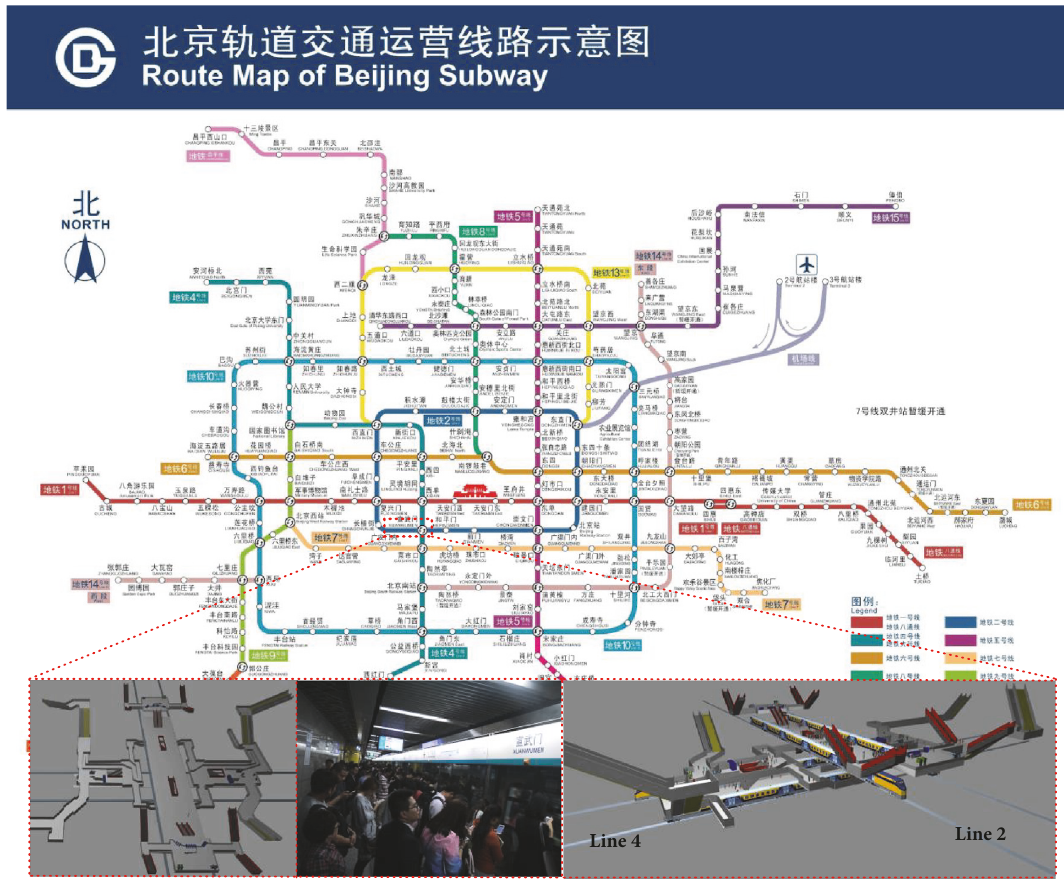
Figure 7: The location of Xuanwumen subway station in the Beijing subway